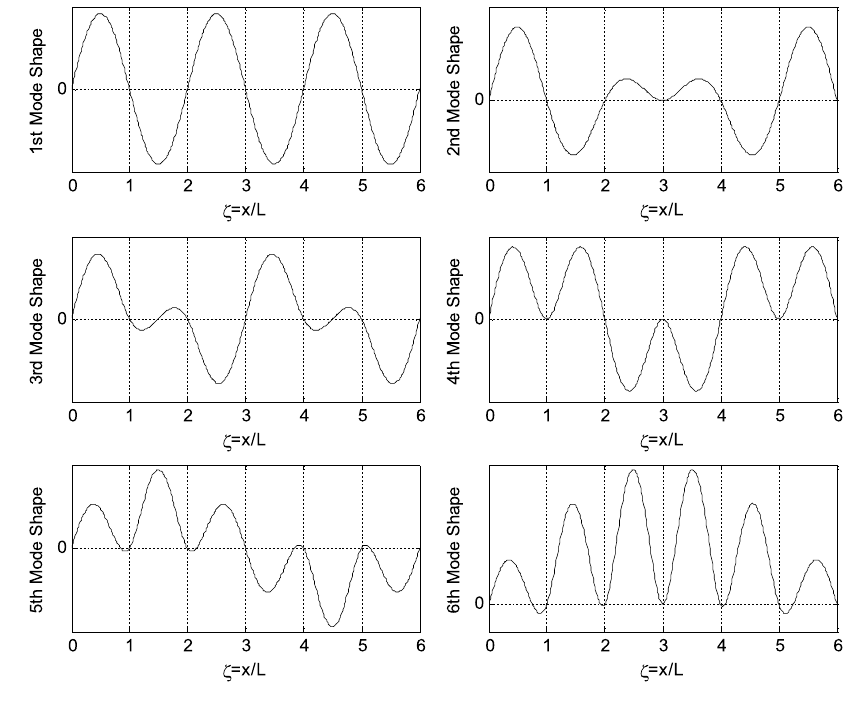
Fig. 4. First cluster of mode shapes of the six-span beam.